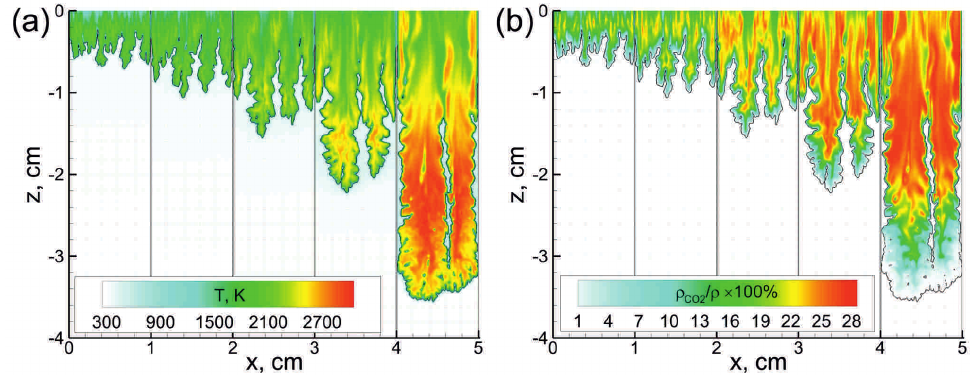
Figure 2. Temperature ( a ) and CO 2 mass fraction ( b ) fields in the vicinity of the flame front (black line) at subsequent time instants starting from 75 µ s with a time step of 30 µ s. The emulsion containing 0.5 vol.% of heptane is foamed with 0.5H 2 + O 2 mixture. z = 0 corresponds to the top open end of the channel.